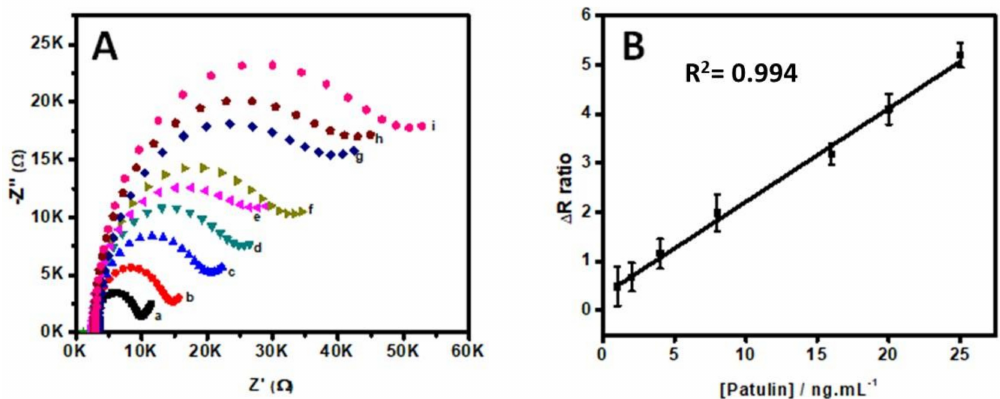
Figure 3. ( A ) Nyquist plot of the aptasensor after incubation with different PAT concentrations: